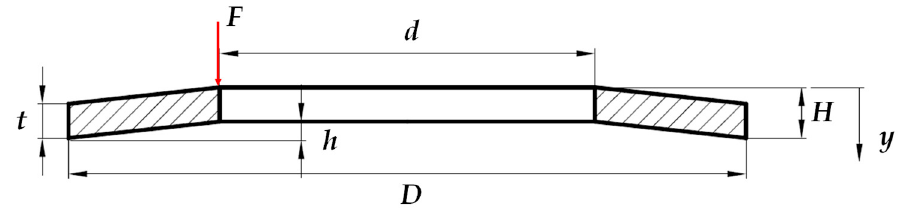
Figure 7. Schematics of the disc spring configurations and dimensional design parameters.